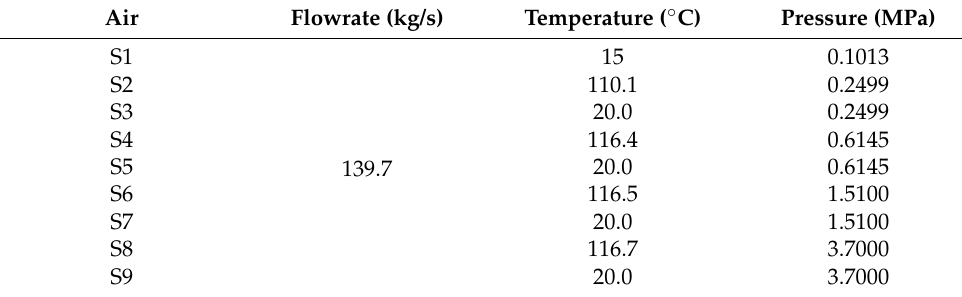
Figure 2. The four stages of the air compression process in Park’s system. Table 1. The parameters of the four stages of the air compression process [5].